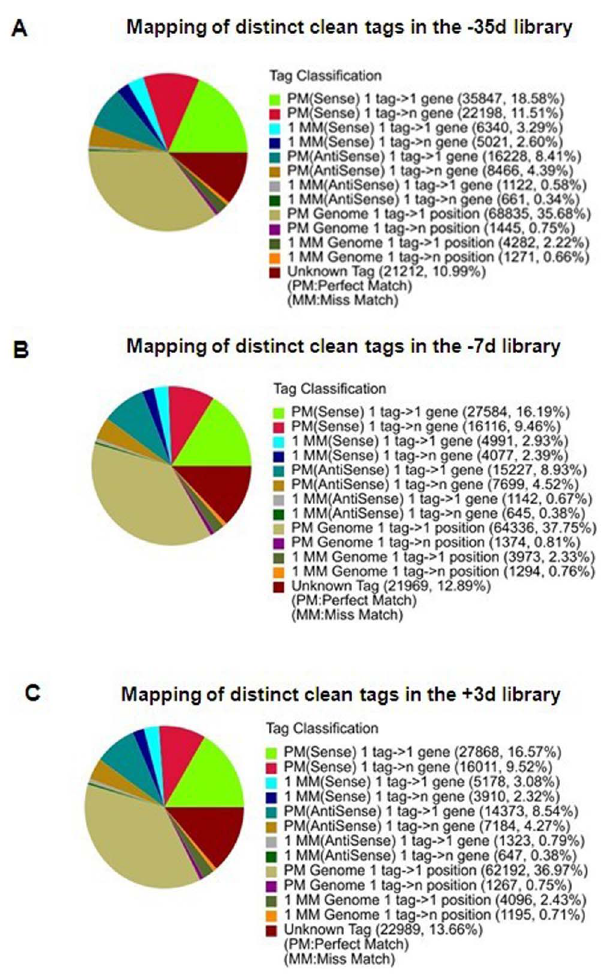
Figure 2. Summary of the distinct tag-to-gene mapping data in the three